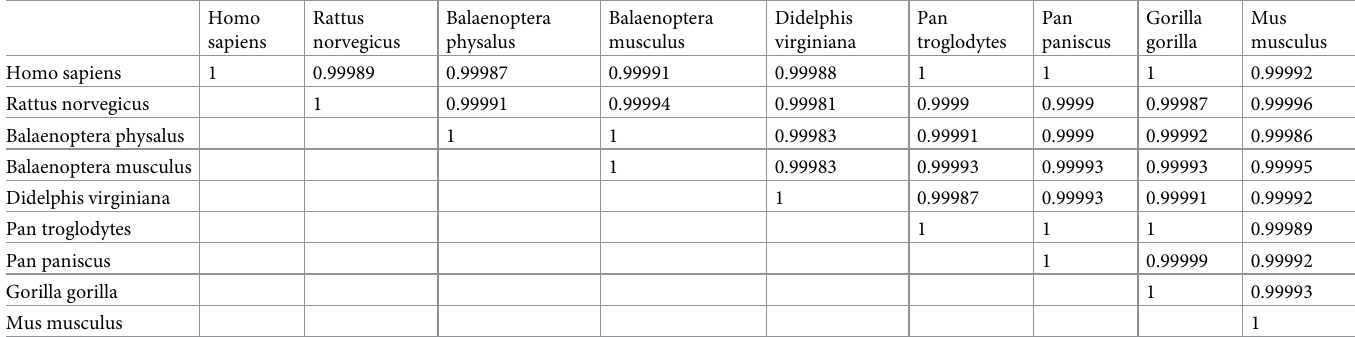
Table 9. The parameter Specification (Spec) of the HELIOS method with referencing the Smith-Waterman algorithm in the accuracy measurement of classification output. The assumed dataset is the “Nine ND5 protein sequences dataset” [53] in this study.